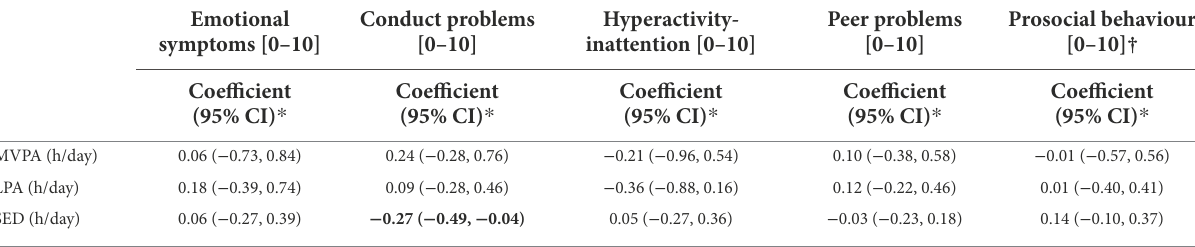
TABLE 3 Association of daily levels of SED, LPA, and MVPA with mental health indicators ( n =